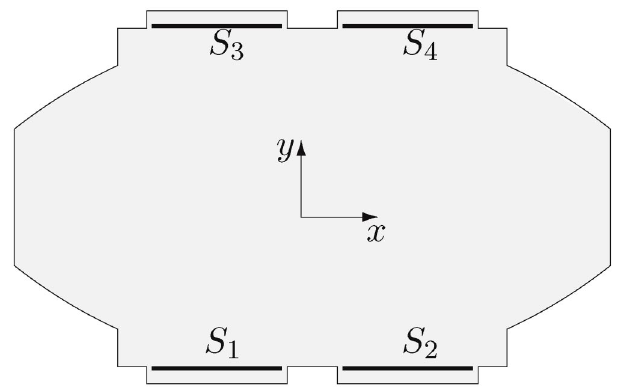
FIG. 1. Arrangement of buttons in CESR arc